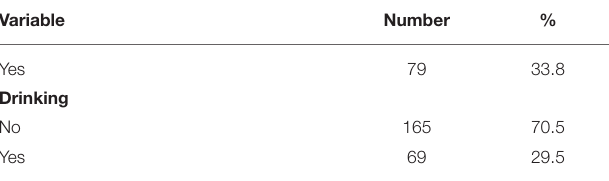
TABLE 1 | Basic information of older cancer patients ( N =